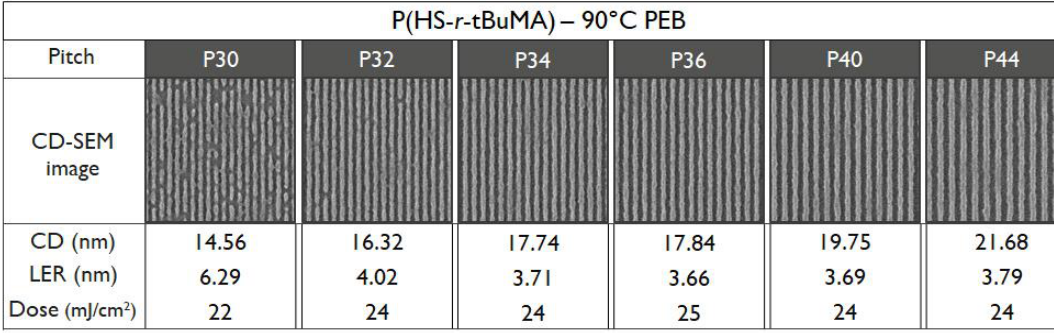
Figure 9. Patterning performance of the P(HS- r -tBuMA) polymer-based resist at 90 °C PEB.